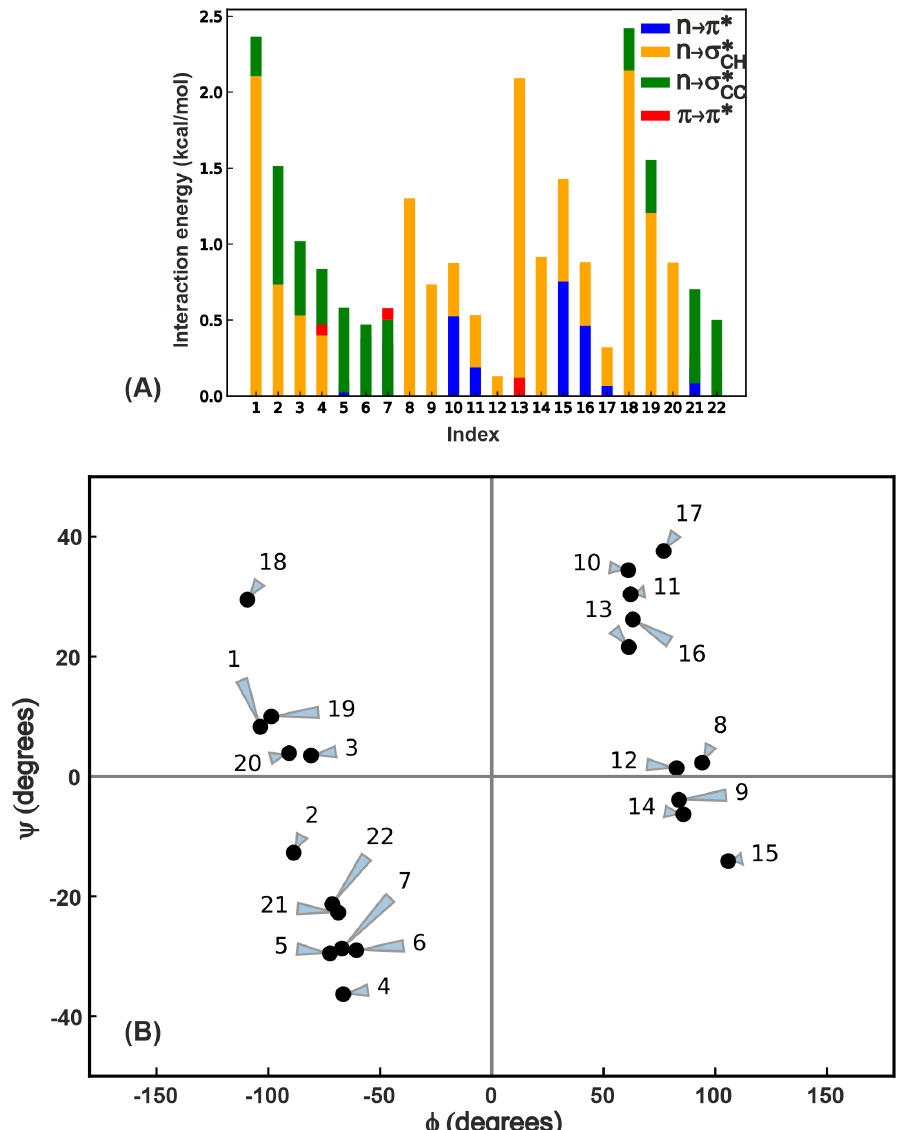
Figure 5. ( A ) Total energy of all long-range interactions in a subset of proteins from the PDB [35] that have β -turns. ( B ) Ramachandran plot of i + 2 residues engaged in four types of i + 1– i + 2 interactions. Each point indicates the ( φ , ψ ) of an i + 2 residue of a β -turn in one of the 22 PDB proteins. There may be more than one interaction for a given i + 2 residue, and this is indicated by the bar plot in ( A ). See SI (Figure S1) for an overlay of this plot with the traditionally allowed regions of various secondary structures in the Ramachandran